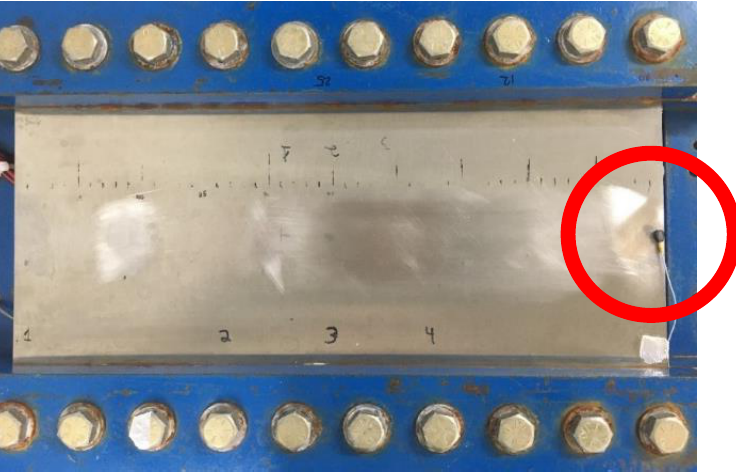
Figure 1. Flat plate experimental setup.